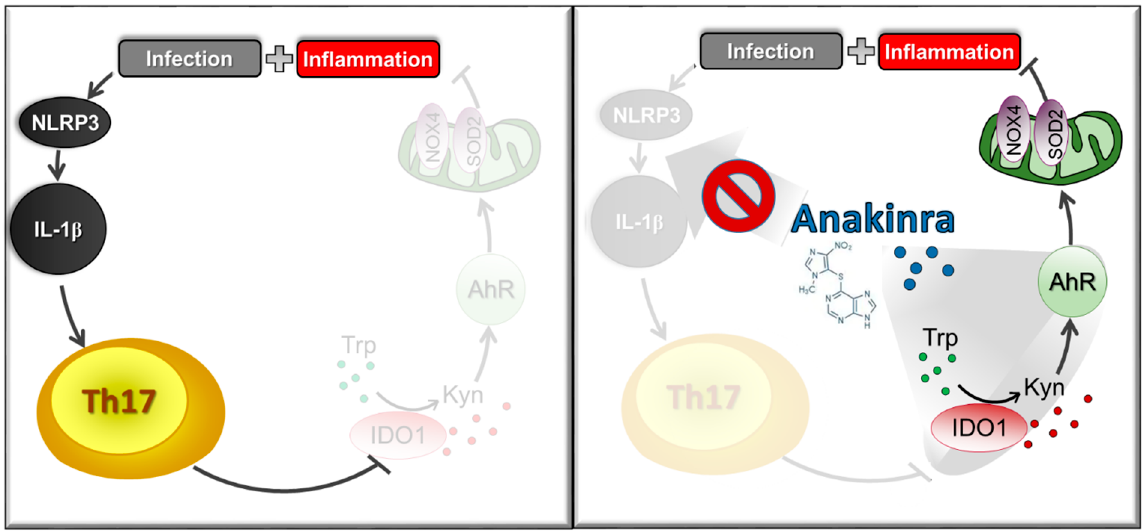
Figure 2. Therapeutic potential of anakinra in lung inflammation. Anakinra prevented the inflammasome NLRP3-dependent IL-1 β production and the subsequent activation of pathogenic Th17 cells ( left side ) but also promoted AhR activation through the IDO1-kynurenine pathway, independent of the IL-1R1 inhibition activity. Via AhR, anakinra transcriptionally activated NADPH oxidase 4 (NOX4) and Superoxide dismutase (SOD) 2, eventually leading to autophagy-dependent control of inflammation ( right side ) (see text for the explanation).